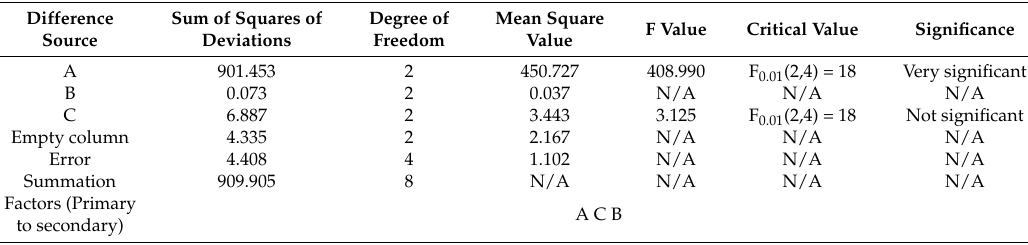
Figure 9. Trend chart of the impact force of the high-pressure water jet produced by straight cone nozzles with different structures. Table 6. Variance analysis of the impact force of the high-pressure water jet produced by straight cone nozzles with different structures.